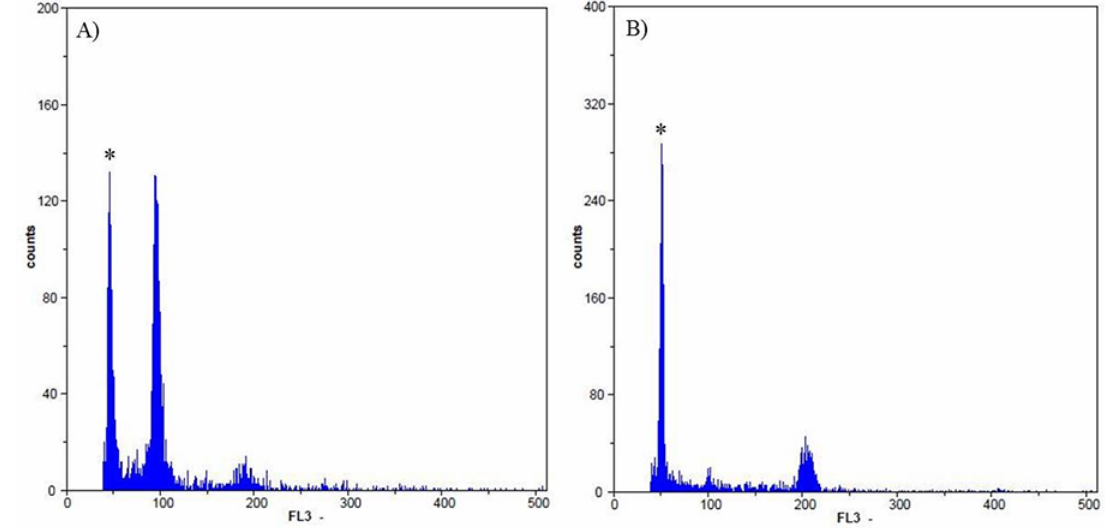
Fig. 1 Representative flow cytometric histograms of leaf DNA content of H. lupulus (Clone 72, Sample 25) grown under in vitro conditions and internal Glycine max standard. ( A ) Diploid control plants without oryzalin treatment and standard (*). ( B ) Tetraploid and standard